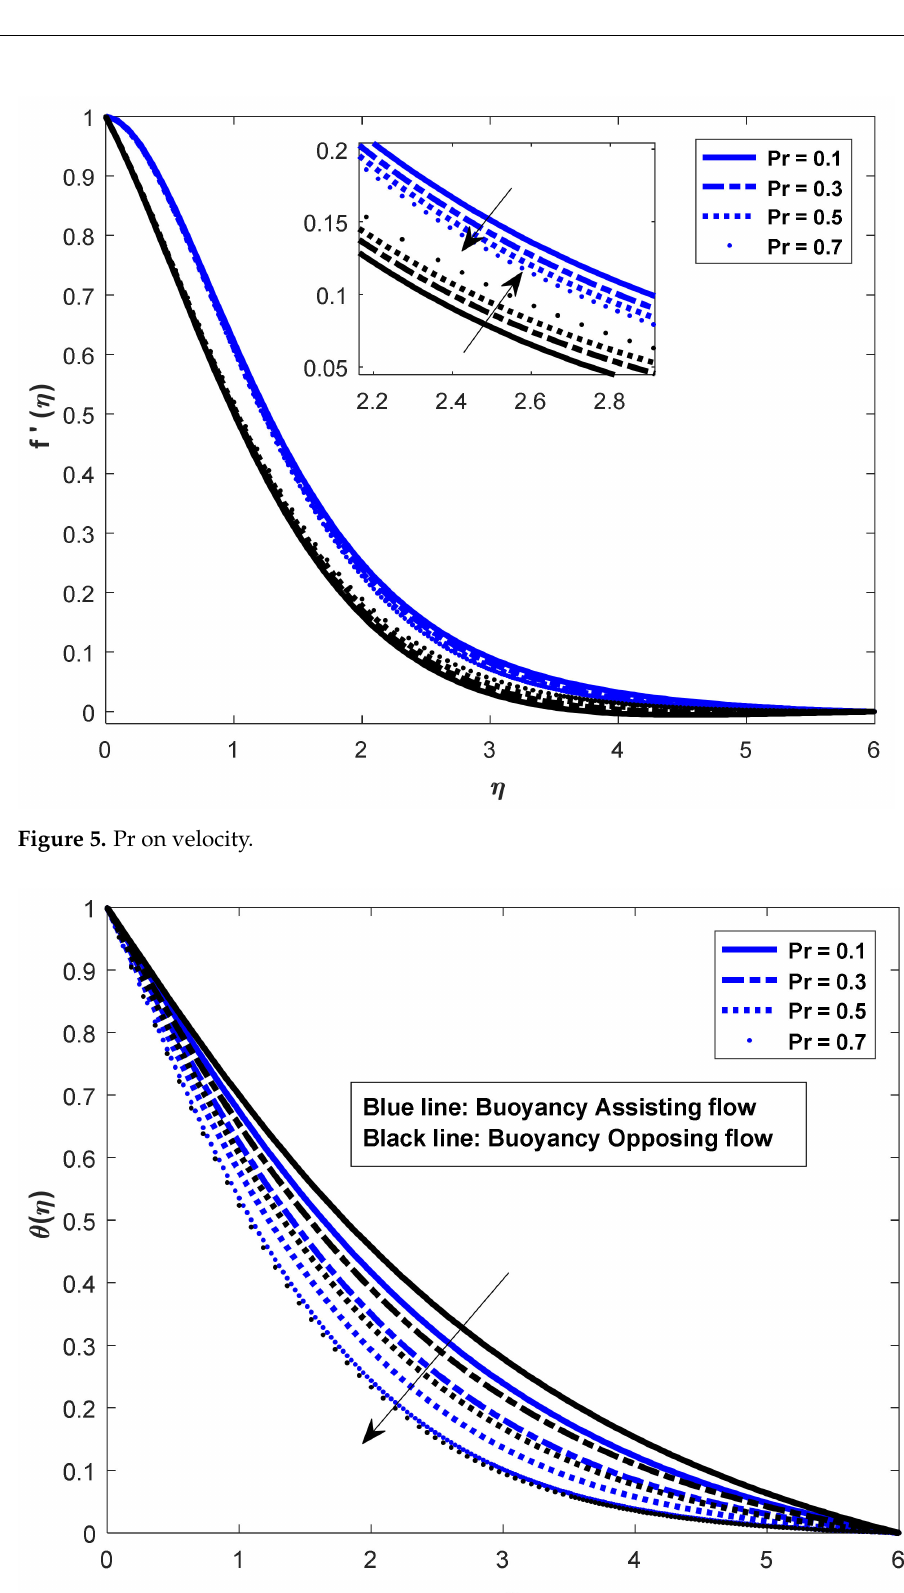
Figure 6. Pr on velocity